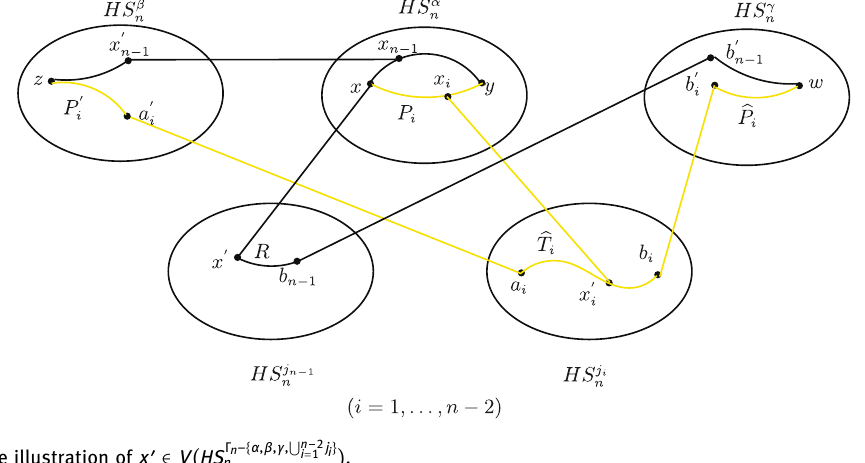
Figure 12: The illustration